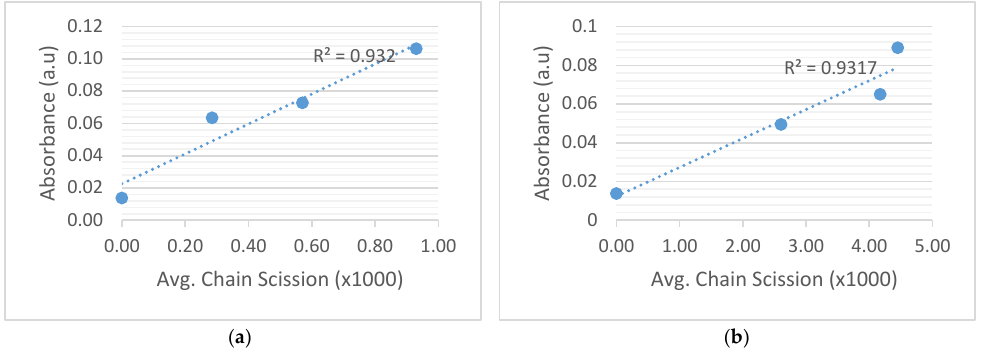
Figure 12. Correlation between average number of chain scission of transformer insulation paper and intensity of peaks absorbance of C=O functional group (1743 cm −1 ) at aging temperature ( a ) 120 °C; ( b ) 150 °C.